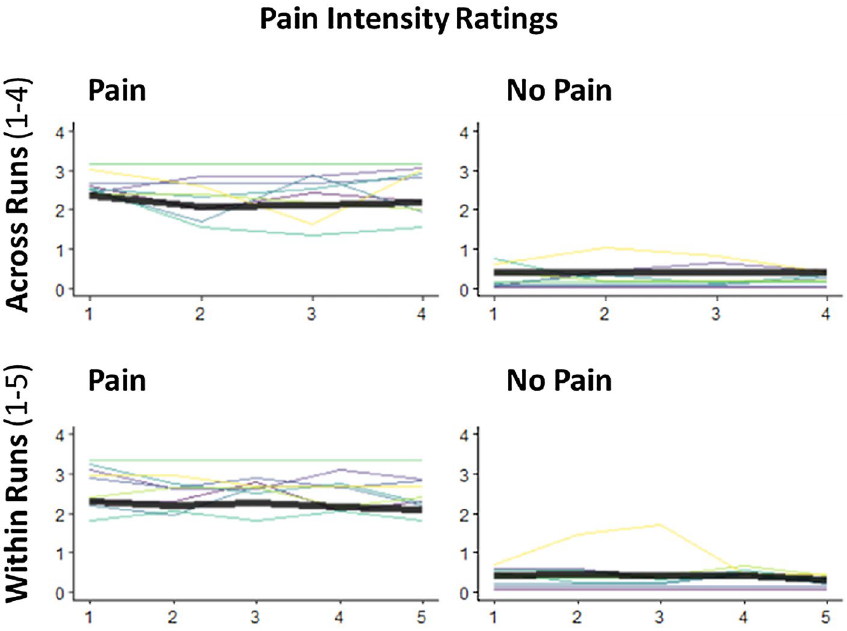
Figure 5. Subjective Ratings of Pain Intensity. Average ratings of experienced pain “1 = detectable sensation” to “4 = worst imaginable pain” are shown over a) runs (upper row) and within Runs (lower row), separately for painful and non-painful stimulation. Bold black lines correspond to mean rating across subjects; color lines correspond to individual ratings averaged across